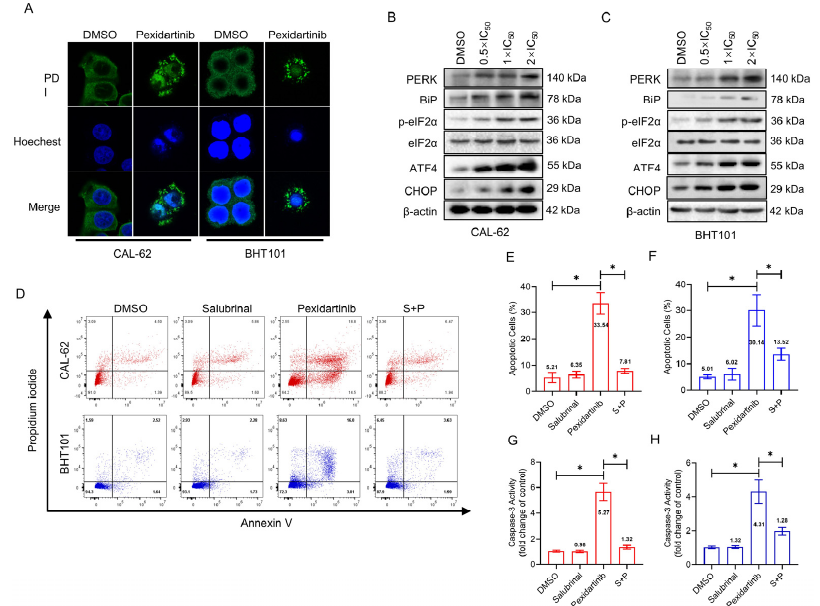
Figure 3. Pexidartinib induces apoptosis in ATC cells in an ER stress ‐ dependent manner: ( A ) Im ‐ munofluorescence detection of protein disulphide isomerase (PDI). ( B , C ) PERK ‐ dependent molec ‐ ular pathway protein alteration in ER stress detected by Western blot. ( D ) Apoptotic cells detection in CAL ‐ 62 and BHT101 cells after salubrinal treatment or combination of salubrinal with pex ‐ idartinib. ( E , F ) Statistical analysis of apoptotic cells detected in CAL ‐ 62 and BHT101 cells after sa ‐ lubrinal or combination of salubrinal with pexidartinib. ( G , H ) Alteration of Caspase ‐ 3 activity de ‐ termined in CAL ‐ 62 and BHT101 cells after salubrinal or combination of salubrinal with pexidar ‐ tinib. The original blots can be found in Figure S1. Data are presented as mean ± SD in at least three independent experiments (significance is presented as * when p < 0.05).